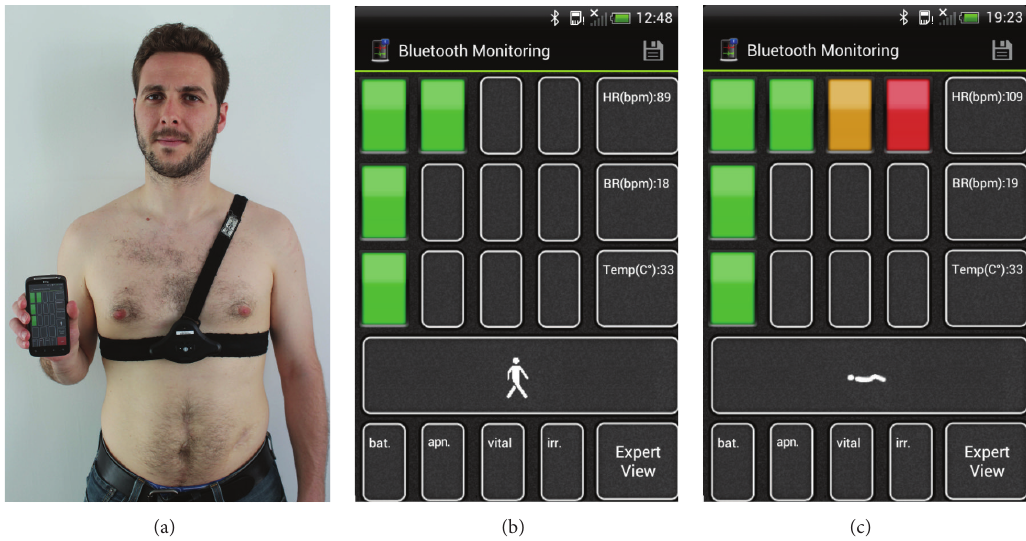
Figure 4: (a) User wearing the EQ01 monitor while holding a smartphone running the PhysioDroid app. (b) Screenshot from the user monitoring view. Example for an apparently normal physiological status. (c) An anomalous situation regarding the measured HR is